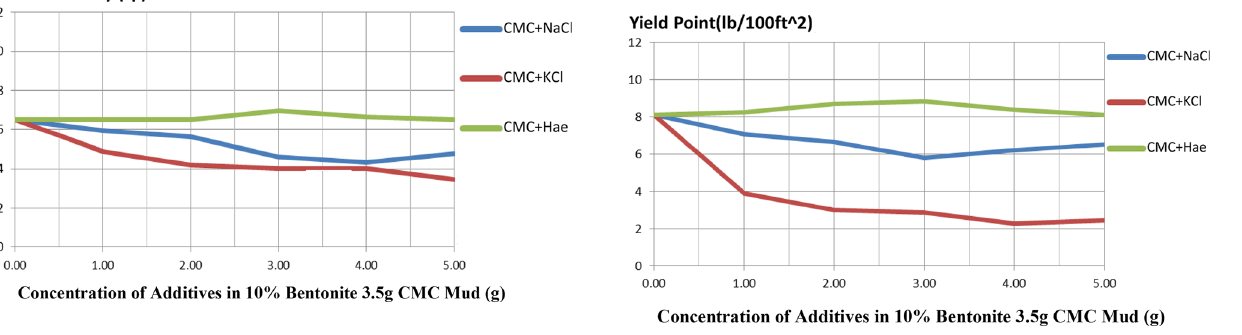
Fig. 4 Effect of NaCl, KCl and haematite on plastic viscosity of CMC–bentonite mud